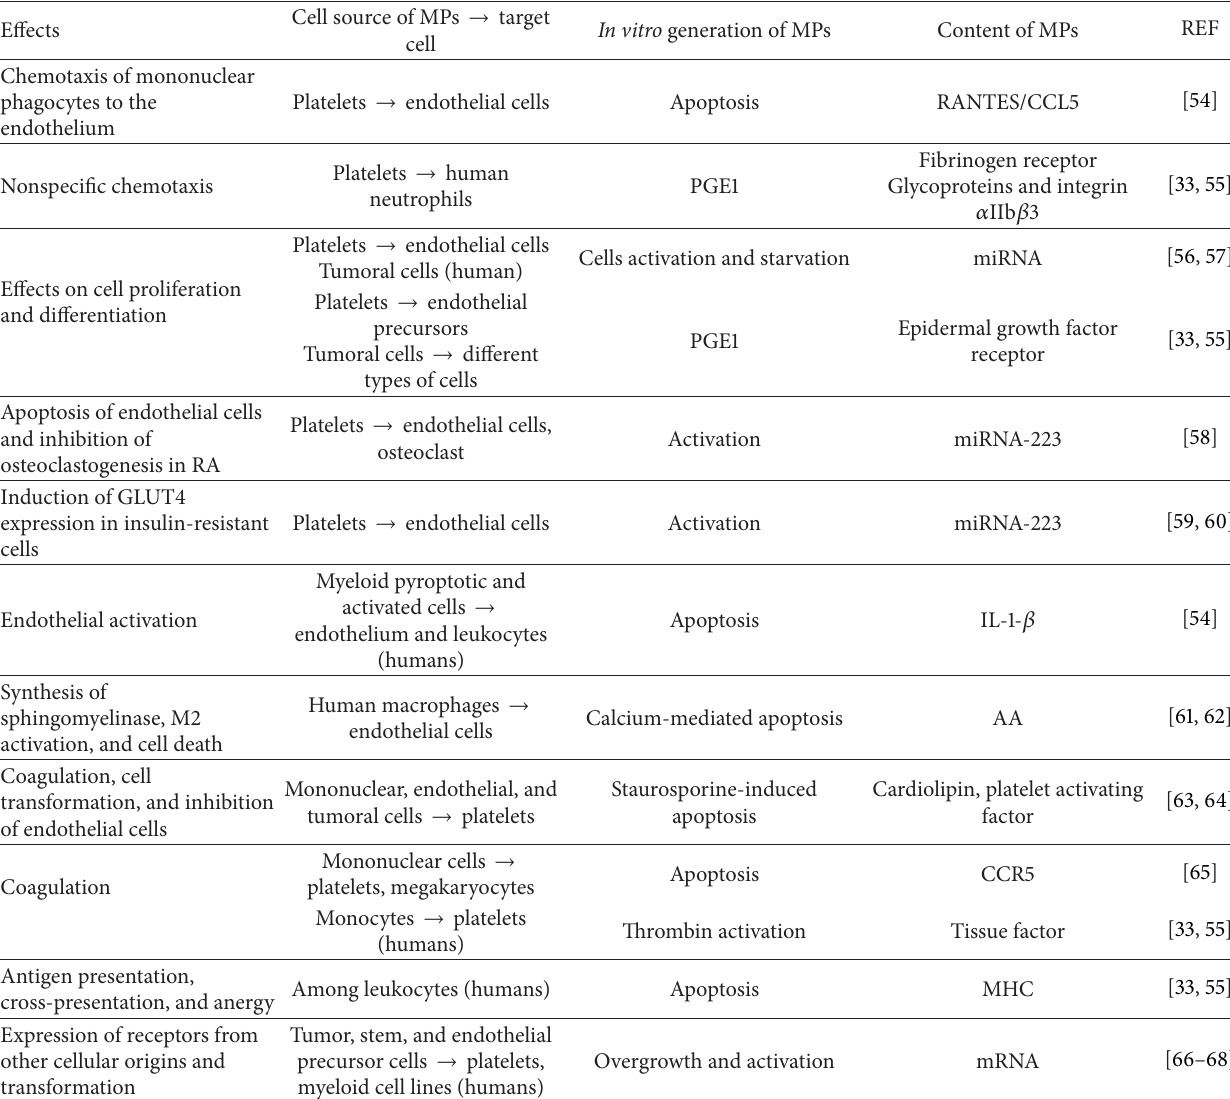
Table 2: MPs as mediators of communication between